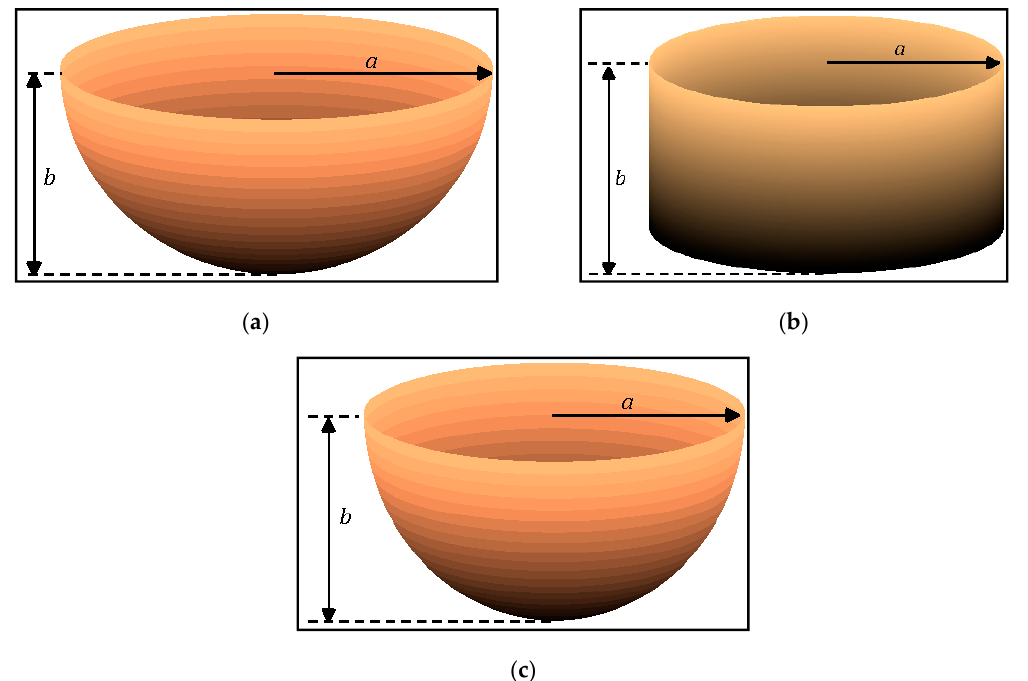
Figure 2. Schematic representation of the wetted surfaces of the WECs’ geometries: ( a ) Oblate spheroid, ( b ) cylinder, and ( c ) hemisphere.